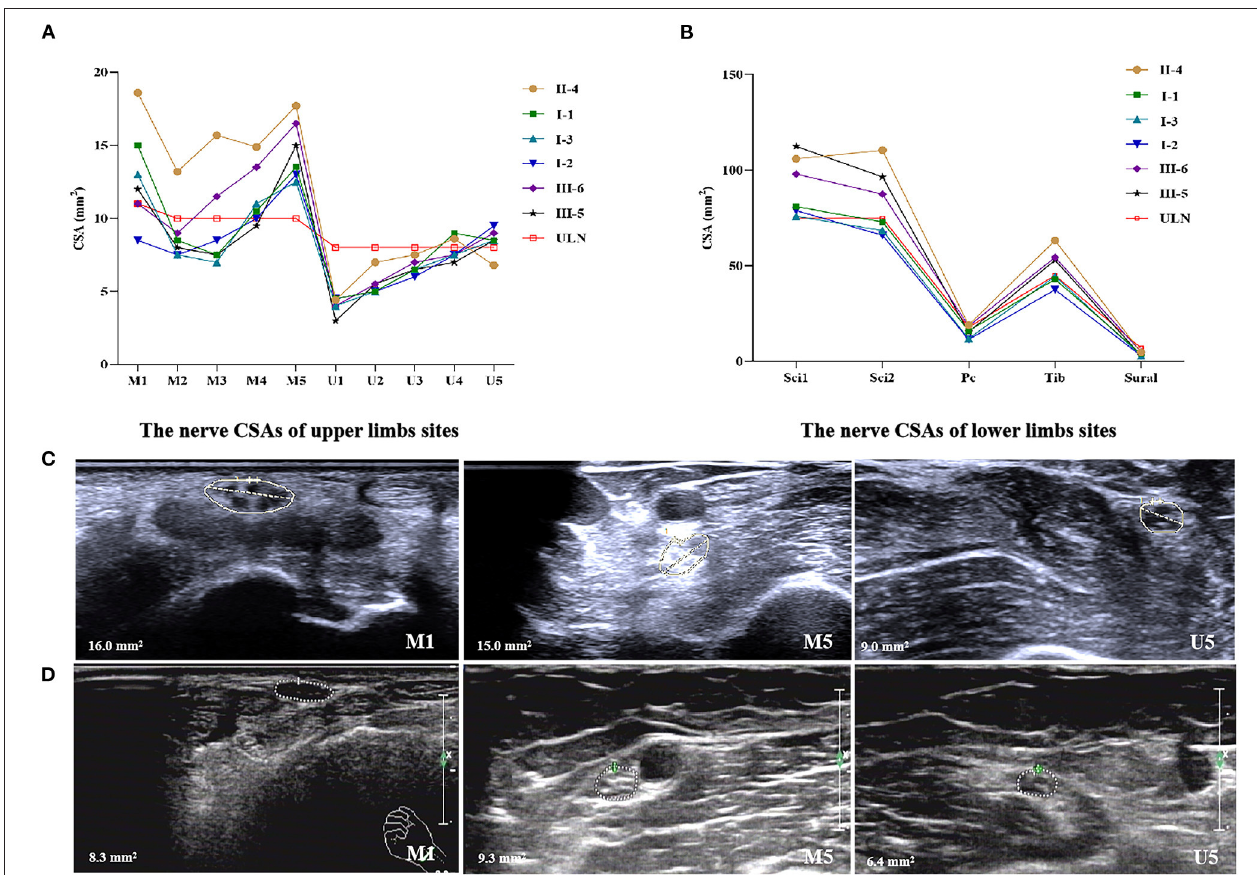
FIGURE 2 | Nerve ultrasonography of patients with Gly83Arg mutation-related ATTR. (A) The nerve CSAs of upper limbs sites. (B) The nerve CSAs of lower limbs sites. (C) Enlargement of CSAs at the site of M1, M5, and U5 of patient III-5. (D) The same sites of healthy control. ULN, upper limit of normal in our center. (1) 10 sites that were measured in median nerves: M1, wrist (entrance to the carpal tunnel at the pisiform bone level); M2, distal forearm (the nerve reached the deep flexor digitorum and started to traverse between the deep flexor digitorum and the flexor pollicis longus); M3, proximal forearm (the clearest point before the nerve entered pronator teres); M4, elbow (elbow socket); M5, upper arm (from cubital fossa to the middle of the armpit). (2) Ten sites of ulnar nerves: U1, wrist (Guyon tube: between the pisiform bone and ulnar artery); U2, distal forearm (before the ulnar nerve branches off); U3, proximal forearm (2/3 between the wrist and elbow); U4, elbow (at the medial epicondyle of humerus); U5, upper arm (from cubital fossa to the middle of the armpit). (3) Four sites of sciatic nerves: Sci1, middle thigh; Sci2, 1/3 of mid-lower part of the thigh (before sciatic nerves were divided into common peroneal nerves and tibial nerves). (4) Two sites of tibial nerves: Tib, popliteal fossa (just after the tibial nerves were branched off by sciatic nerves). (5) Two sites of common peroneal nerves: Pc, capitulum fibulae. (6) Two sites of sural nerves: sural, lower 1/4 of the lower leg near lateral